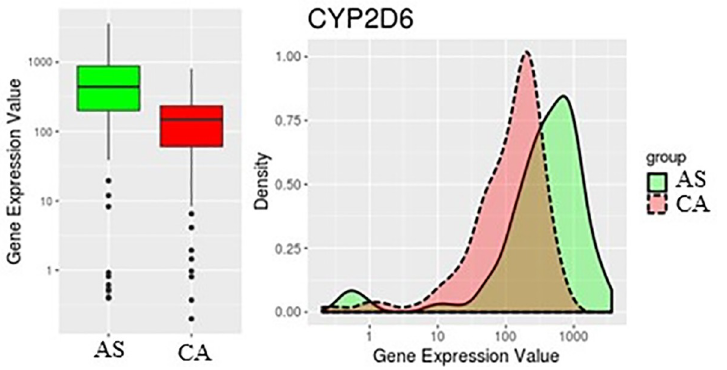
Fig 3. Expression levels of CYP2D6 in AS and CA groups. CYP2D6 is higher in AS than CA.